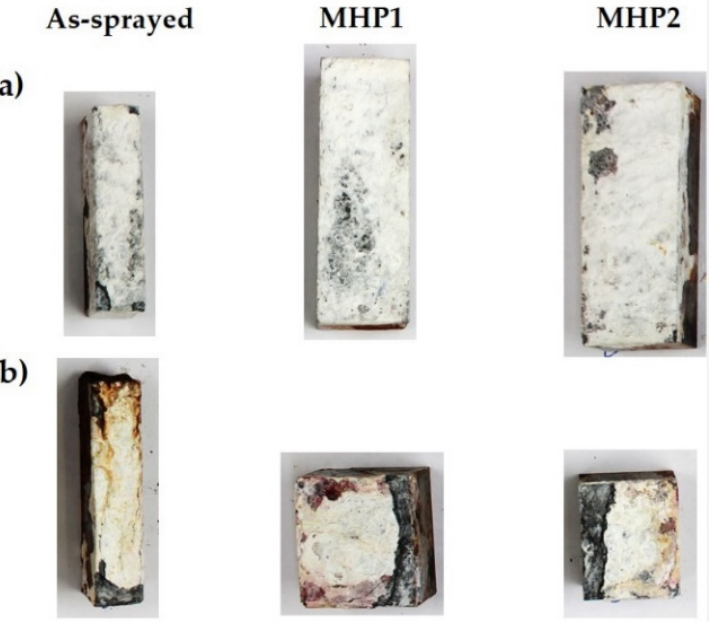
Figure 14. White corrosion products of ZnAl4 TWAS sprayed coatings: ( a ) using compressed air and ( b ) using argon as atomization gas.